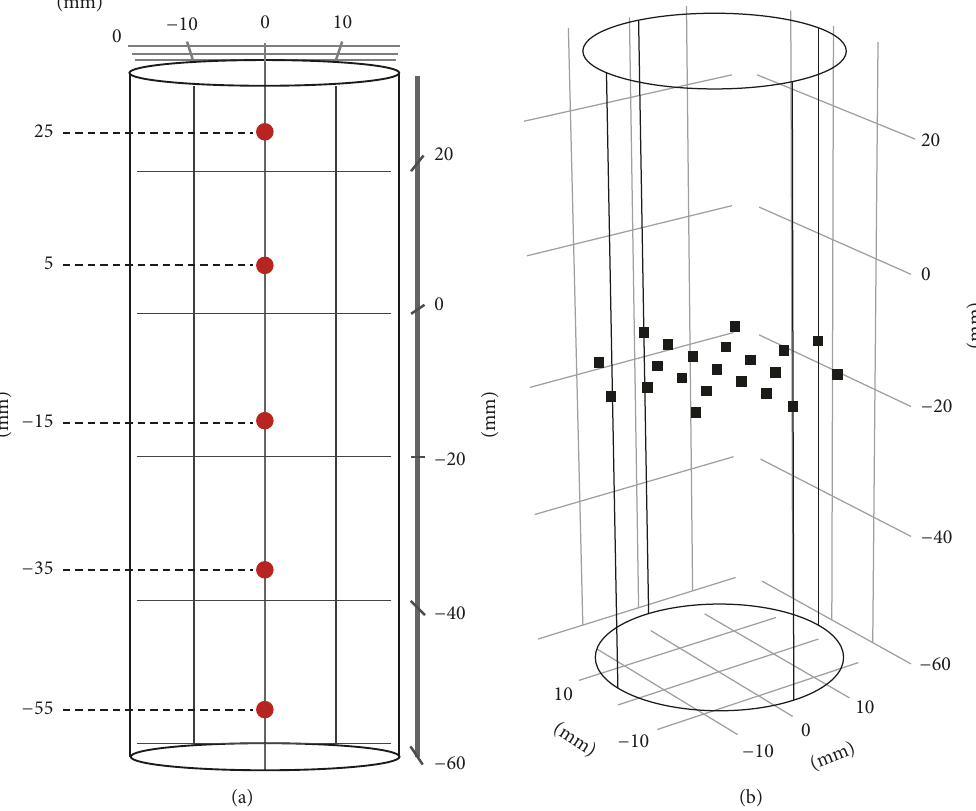
Figure 3: Model structure of vial in simulation of COMSOL